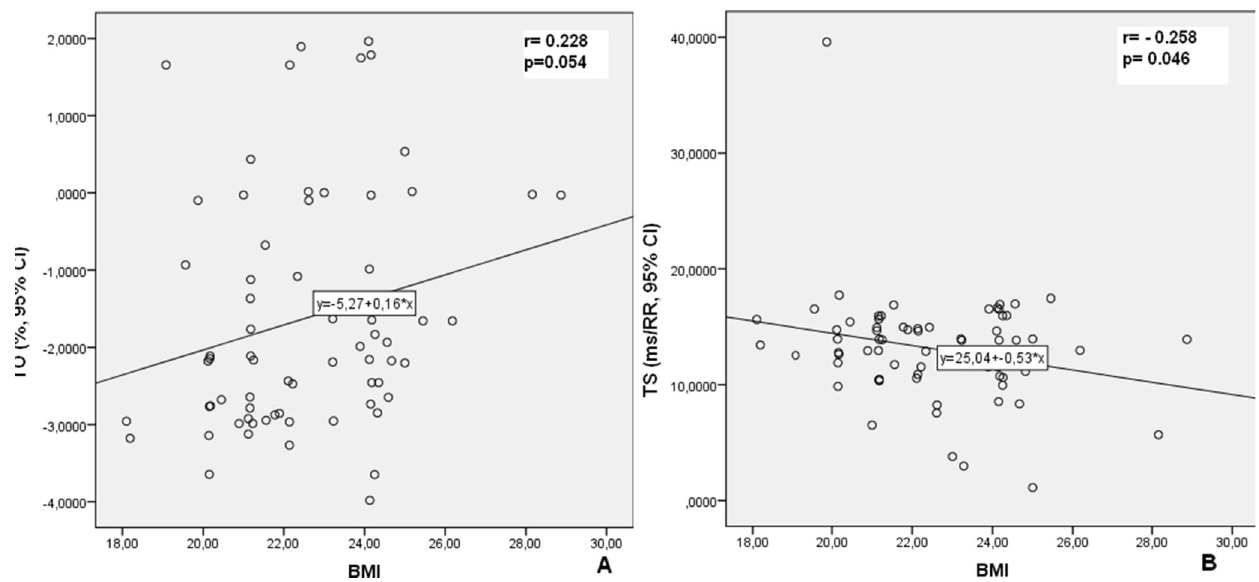
Figure 2 - Pearson correlation analysis of variables. A ) Turbulence Onset and Body Mass Index; B ) Turbulence Slope and Body Mass